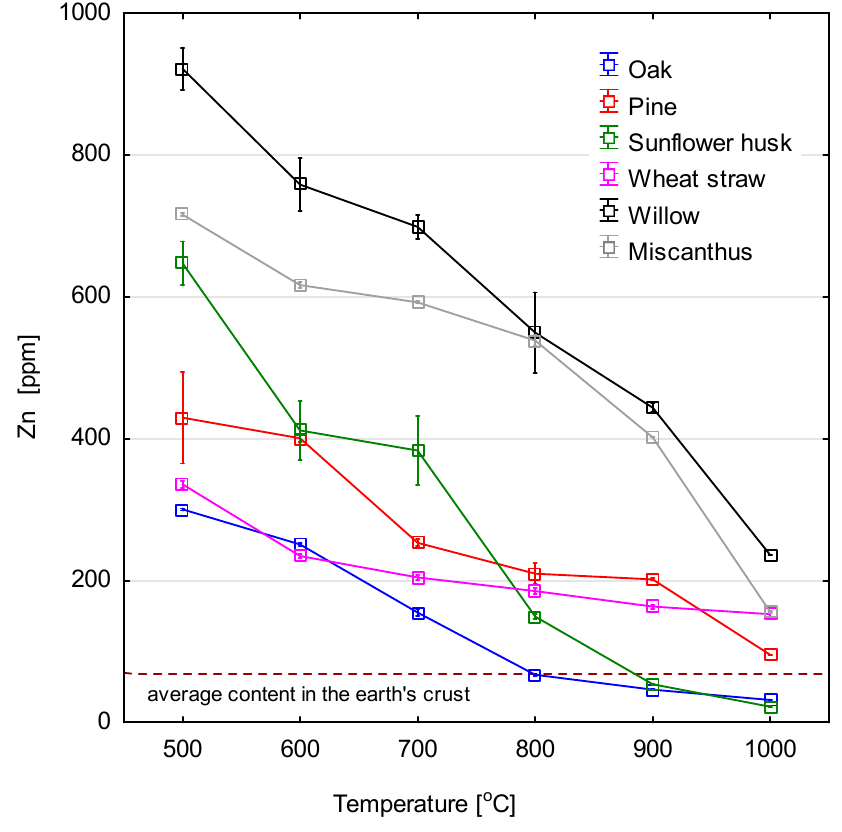
Figure 3. Changes in Zn content in the examined biomass depending on ash-forming temperature.